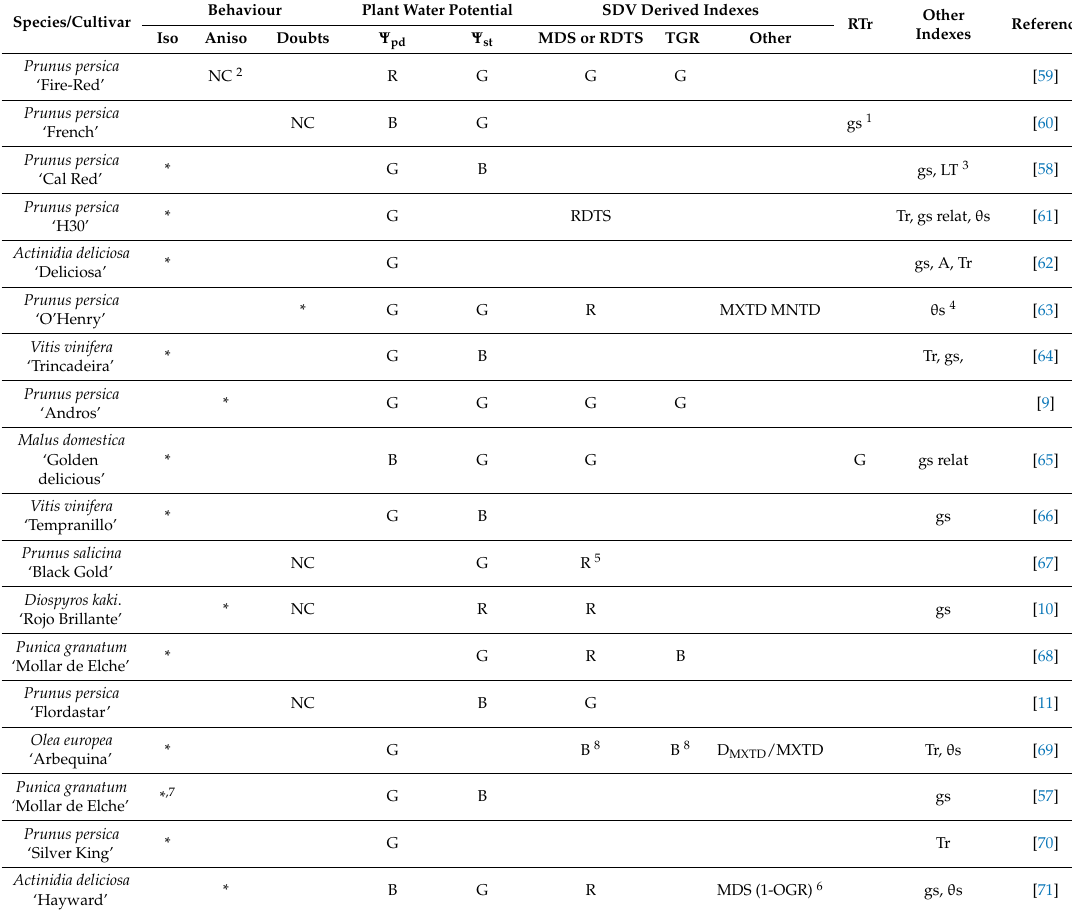
Table 2. Plant indicators used and relationship with isohydricity observed following criteria